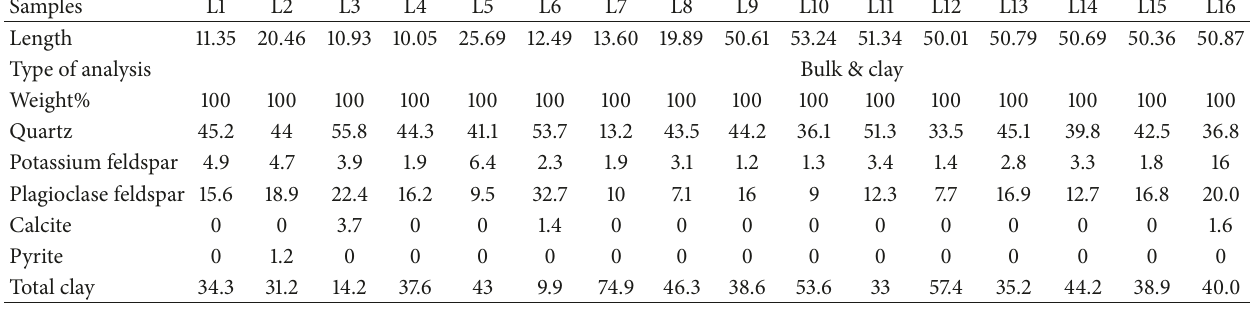
Table 2: Results of XRD mineralogy analyses.